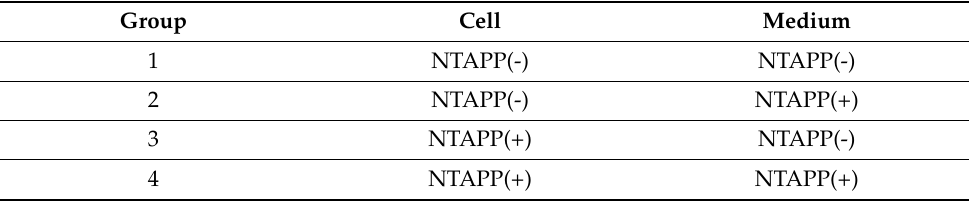
Table 1. Irradiation conditions for cells and culture medium.